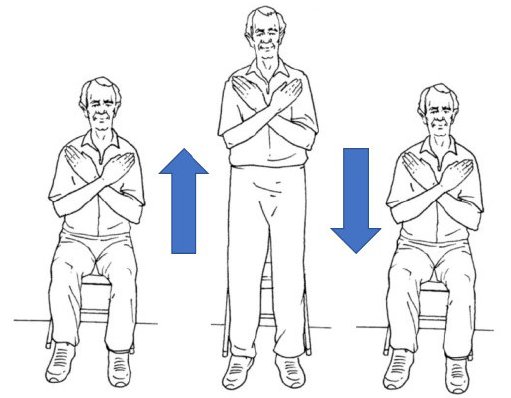
Figure 1. Sit-to-stand